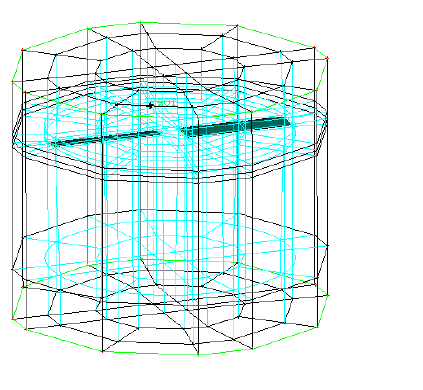
Figure 14. Topology and spatial section of the remodified grid.